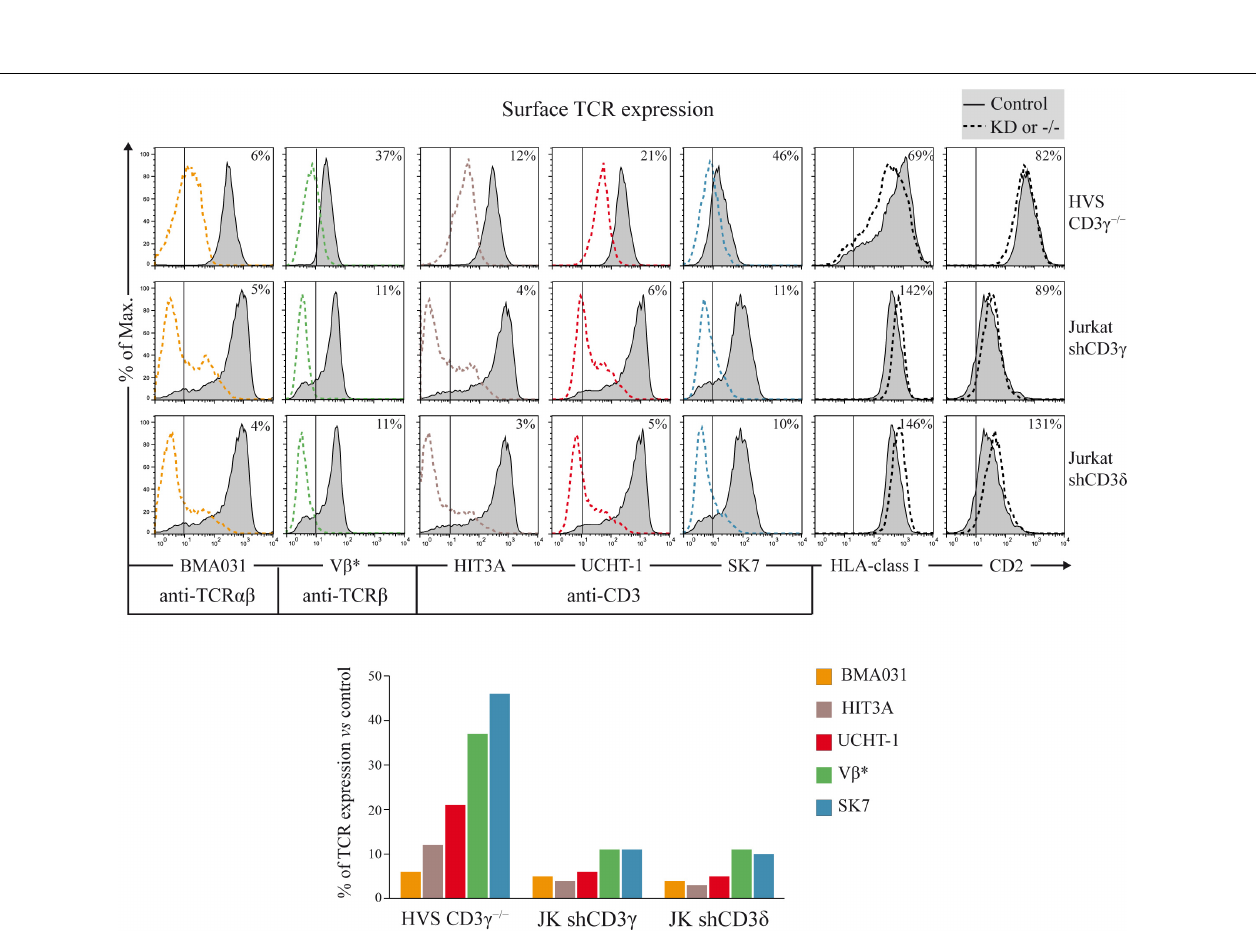
FIGURE 6 | Surface TCR expression in CD3G or CD3D KD T-cell lines. Top: cells were stained with labeled TCR- or CD3-specific mAb (BMA031, HIT3A, UCHT-1, V β *, and SK7) or with TCR-independent control mAb (anti-HLA-class I and anti-CD2). Expression was analyzed in HVS-CD3 γ − / − , Jurkat shCD3 γ , and Jurkat shCD3 δ cells (dashed lines) compared with their relevant controls (HVS-CD3 γ + / + or Jurkat shNT, gray histograms, the latter shown twice as it is the control cell line for both CD3G and CD3D KD cell lines). The vertical line in each panel indicates the upper limit of background fluorescence using isotype-matched irrelevant mAb. The numbers in each histogram indicate geoMFI ratios ( × 100) relative to controls. Bottom: bar representation of TCR/CD3 geoMFI ratios relative to controls. *V β 3- or V β 8-specific mAb was used to stain the TCR β chain in HVS or Jurkat cells, respectively, because they have different TCRB rearrangements.